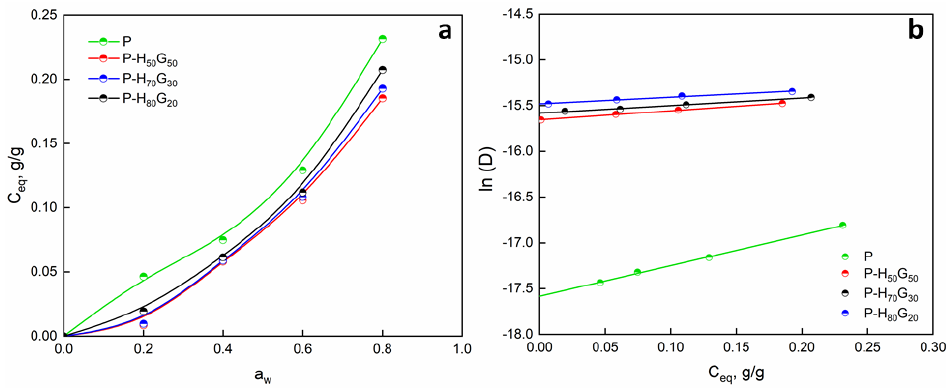
Figure 6. ( a ) Sorption isotherm and ( b ) diffusivity vs. equilibrium concentration of pectin and pectin composites.